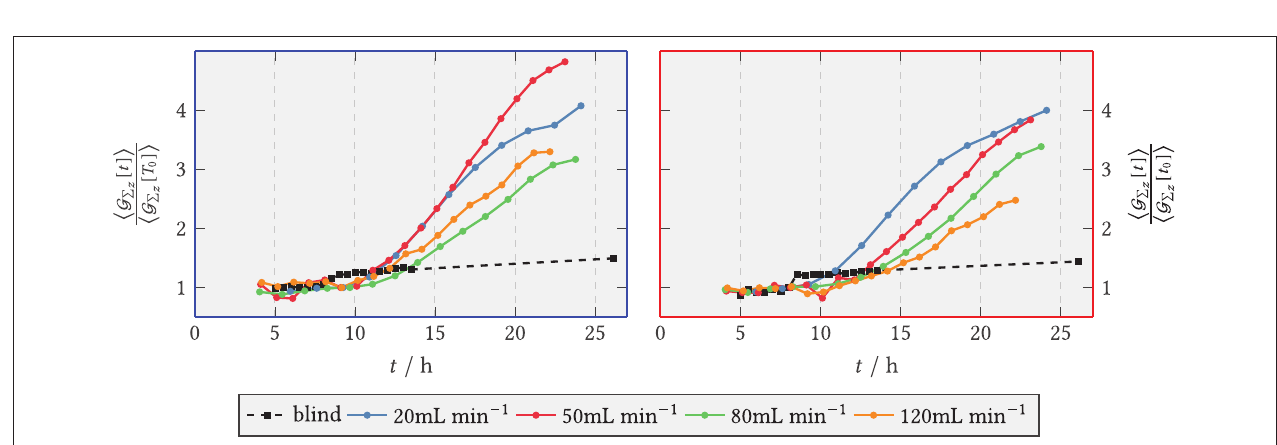
FIGURE 11 | Relative light extinction for ˙ V = 20,50,80,120 mL min − 1 and the blank sample (shear-free medium exchange). The light extinction was normalized to the initial extinction at t 0 = 9 h. The error bars bound the 1 σ interval around the zone mean and quantify the scatter of the extinction per zone. (Left) Zone behind the step (recirculation zone); (Right) Zone downstream of the step, x / s > 15 (after reattachment).